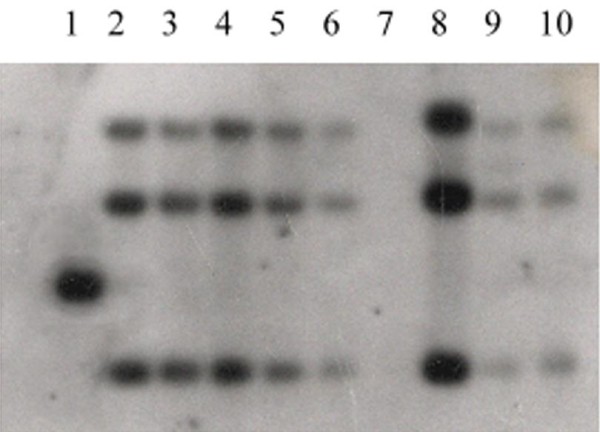
Southern hybridization of fusC. Detection of fusC by Southern hybridization in eight representatives of clinical fusidic acid-resistant S. aureus isolates that did not harbour fusB or resistance polymorphisms in fusA. Lane 1: 2.5-kb PCR fusC fragment from strain 2 as the positive control. Lanes 2-6 and 8-10: strains 3, 6, 15, 18, 24, 28, 29 and 34, respectively. Lane 7: strain 23 without the fusC gene. All total DNA was EcoRI-digested.